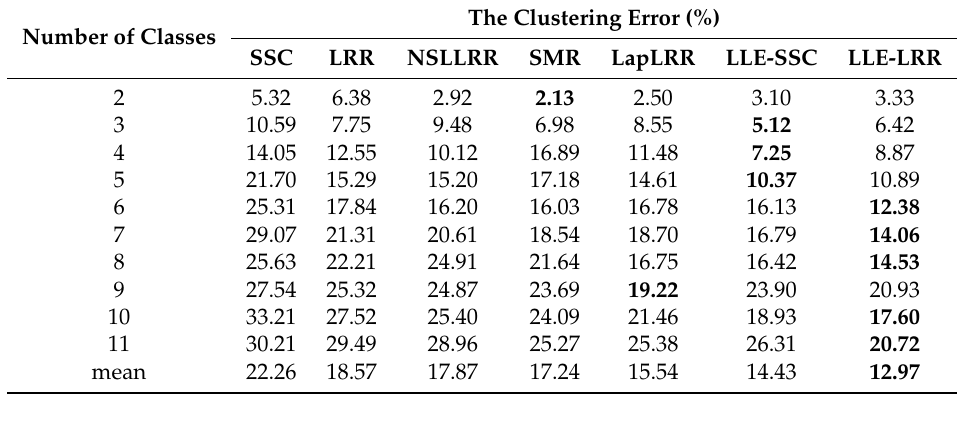
Table 6. Clustering results on COIL20 dataset. The clustering errors for 2,3,4,5,6,7,8,9,10,11 classes and their mean error are shown here. The best results are in bold font.